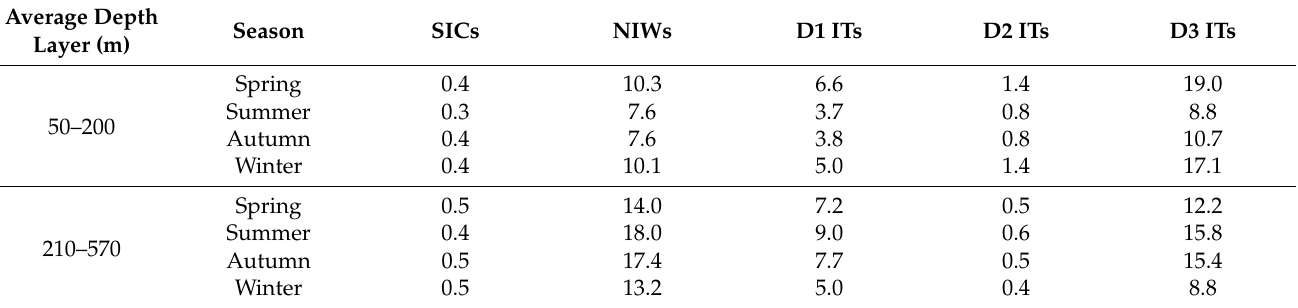
Table 3. The seasonal shear efficiencies of SICs, NIWs, and ITs in the different average depth